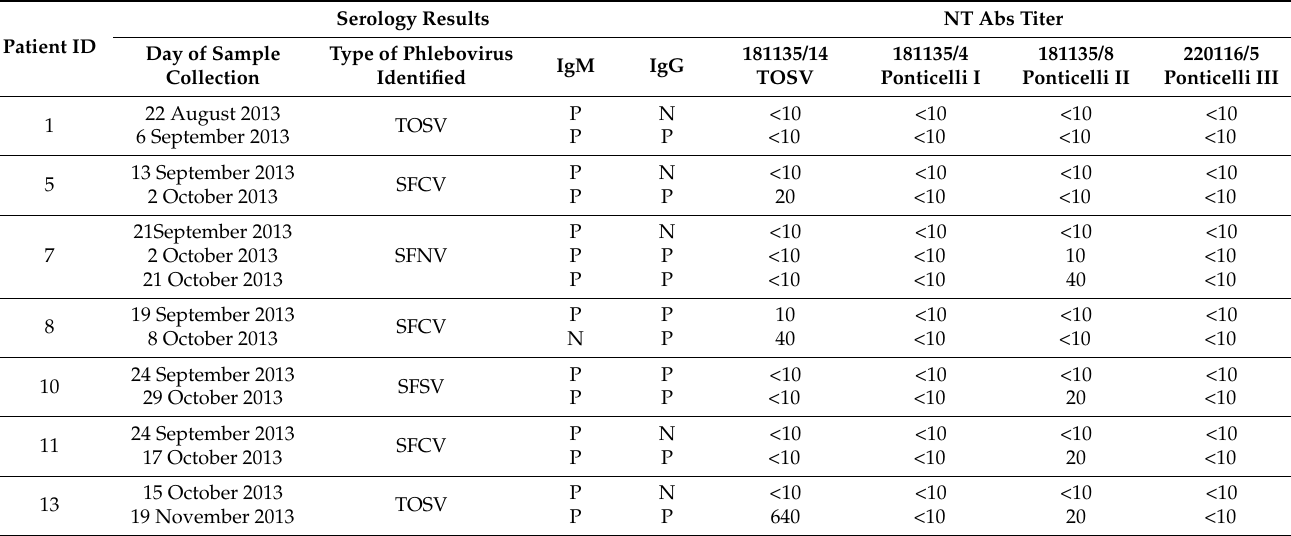
Table 3. Neutralizing antibodies titer against four phlebovirus strains in 7/19 positive patients from the 2013 outbreak.